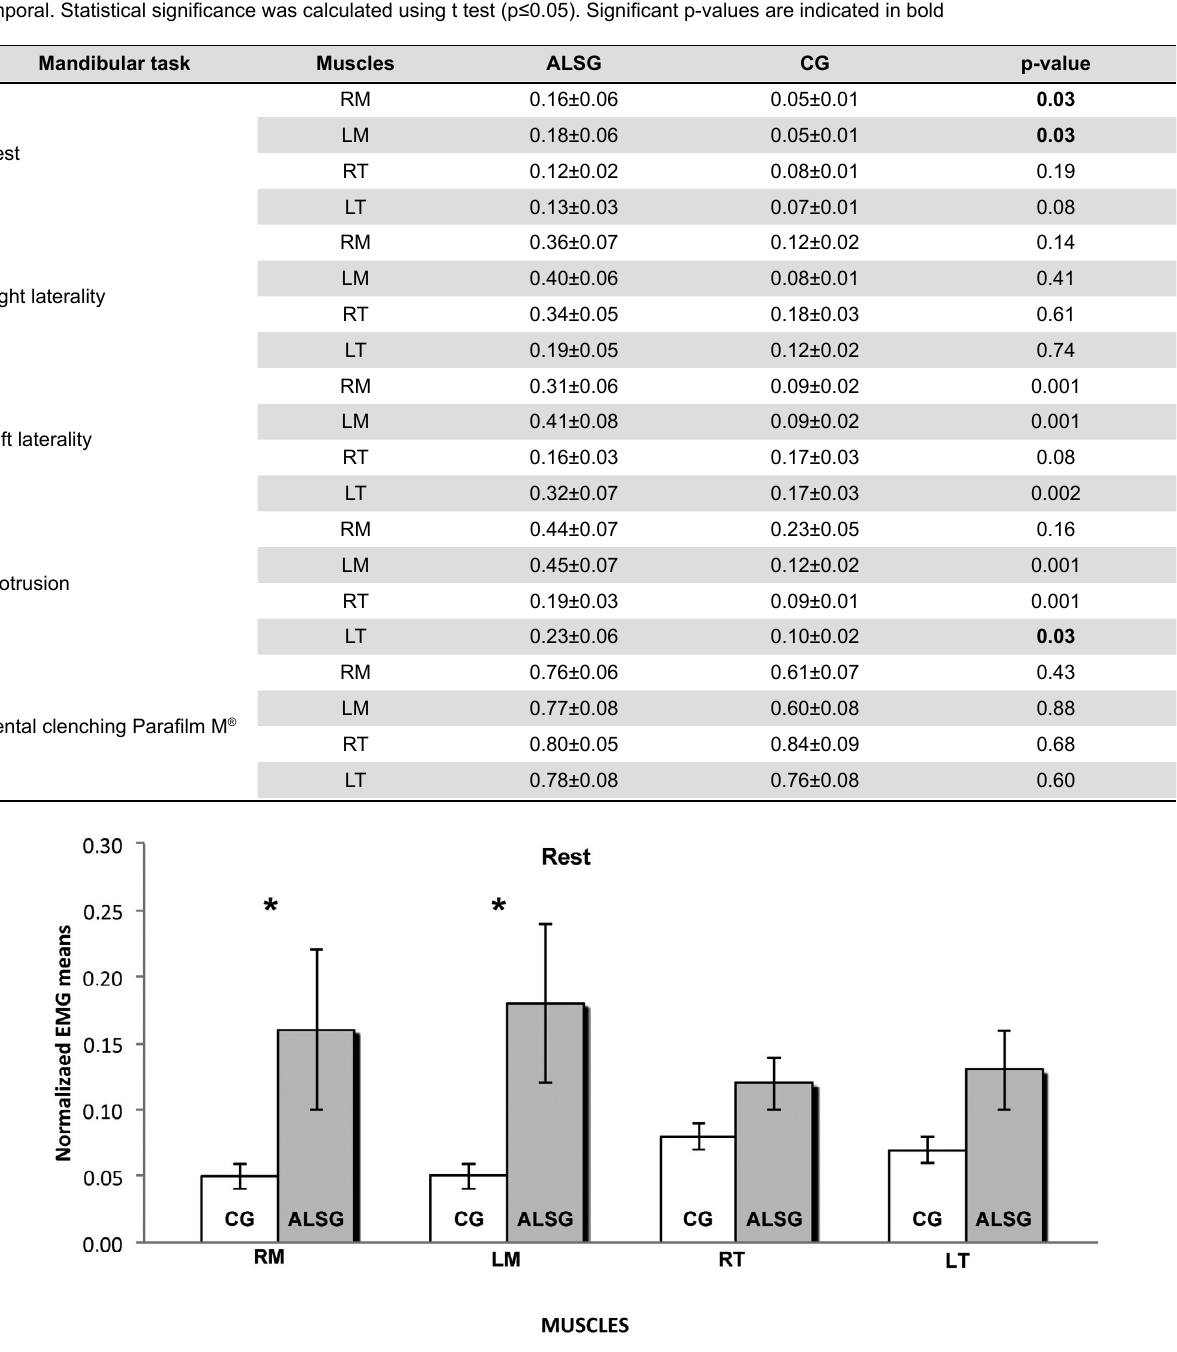
Table 2- Comparison of the mean normalized electromyographic data during mandibular task according to the groups. ALSG: Amyotrophic lateral sclerosis group; CG: control group; SD: standard deviation; RM: right masseter; LM: left masseter; RT: right temporal; LT: left